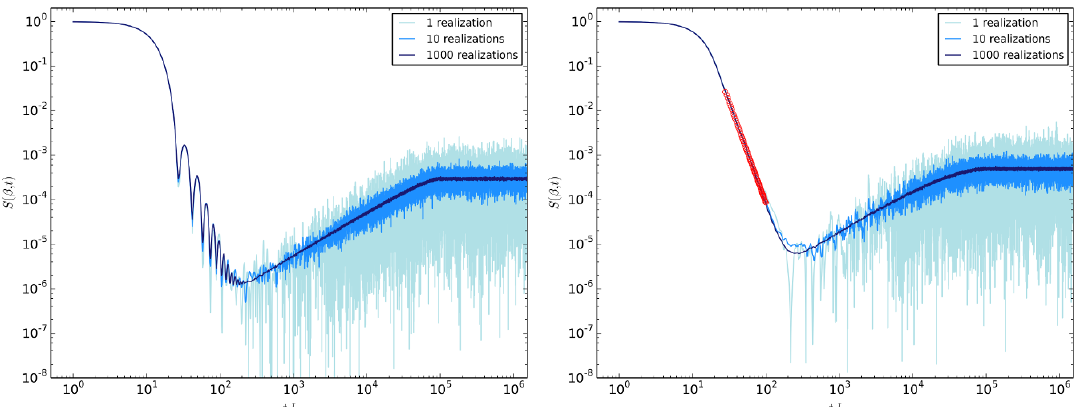
Figure 4 . Spectral form factor at half (cid:12)lling (cid:23) = 1 for varying number of realizations and two 2 di(cid:11)erent temperatures at N = 14. In both cases we see the characteristic decay followed by linear ramp and plateau behavior. Left panel: (cid:12) = 1. One sees several partial revivals in the decaying region with a power-law envelope. Right panel: (cid:12) = 10. The red markers show points we used for a (cid:12)t in the slope region, where we (cid:12)nd a decay of / t (cid:0) 4 : 53 ::: , which is consistent with the value reported in